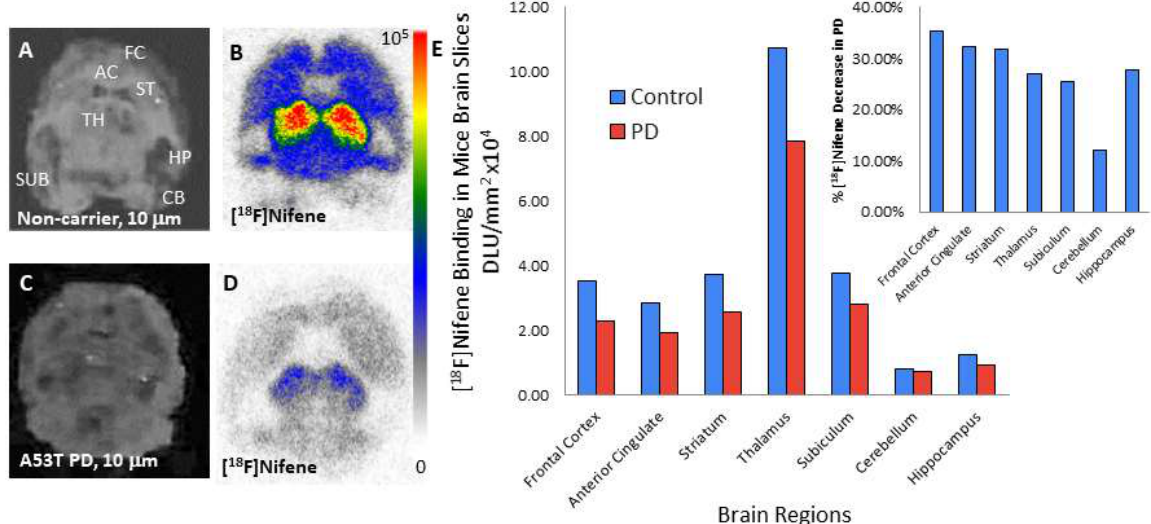
Figure 6. In vitro [ 18 F]nifene in Hualpha-Syn ((A53T) PD mice model: ( A ) Non-carrier mouse brain slice 10 µm thick; ( B ) in vitro autoradiograph of [ 18 F]nifene of non-carrier mouse brain slice; ( C ) A53T PD mouse brain slice; 10 µm thick; ( D ) in vitro autoradiograph of [ 18 F]nifene of Hualpha-Syn ((A53T) mouse brain slice; ( E ) comparison of [ 18 F]nifene in non-carrier mice (n = 3) and Hualpha-Syn ((A53T) PD mice (n = 3) in different brain regions. Inset in ( E ) shows percent decrease of [ 18 F]nifene binding in A53T PD mice compared to non-carrier mice ( p < 0.05 for frontal cortex, anterior cingulate, striatum, and thalamus; not significant for subiculum, cerebellum, and hippocampus).